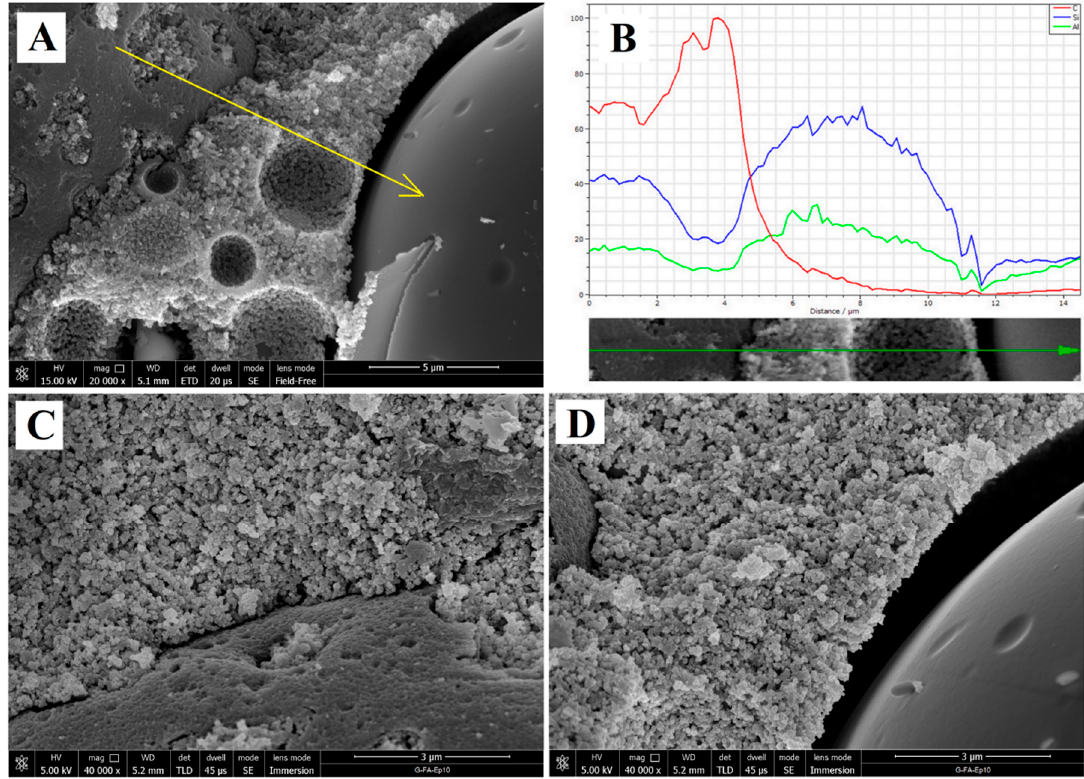
Figure 8. SEM image of the sample G-FA-Ep10: ( A ): magnification at 20,000× of a part of Figure 6B’ that shows, following the direction of the yellow arrow: (i) the resin particle; (ii) the matrix and (iii) the not-reacted ash particle; ( B ) % distribution of C ( red ), Si ( blue ), Al ( green ) along the arrow obtained by EDS analyses; ( C , D ) 40,000× magnification image of the interface zone between the geopolymer matrix and a resin particle, and between the matrix and an ash particle, respectively.